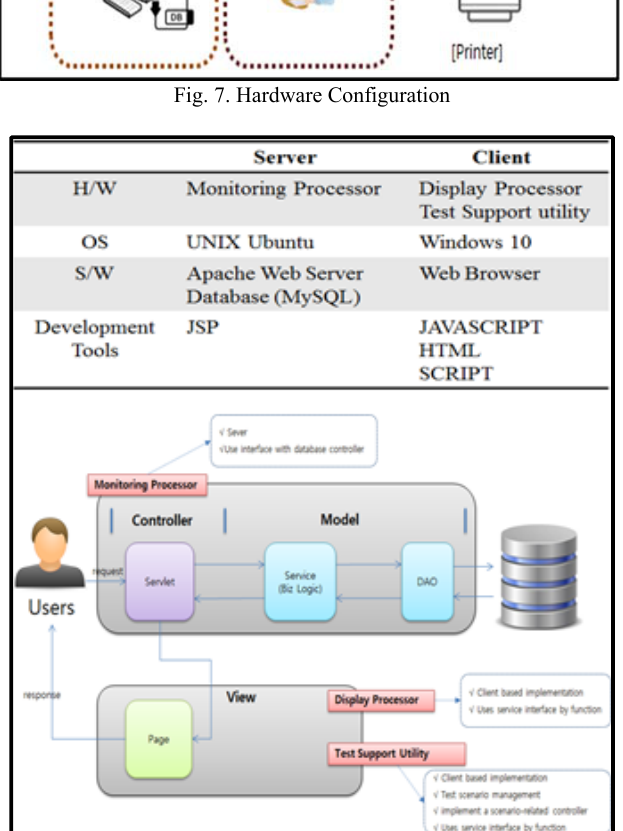
Fig.8. Software Configuration (cid:71)